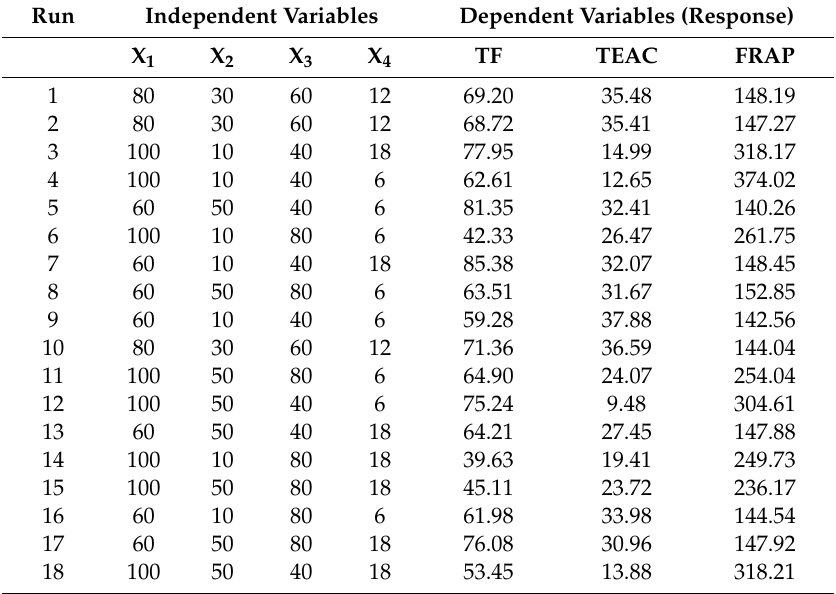
Table 2. Central composition design and response values of the total flavonoid contents and antioxidant activity of the D, morbifera leaf